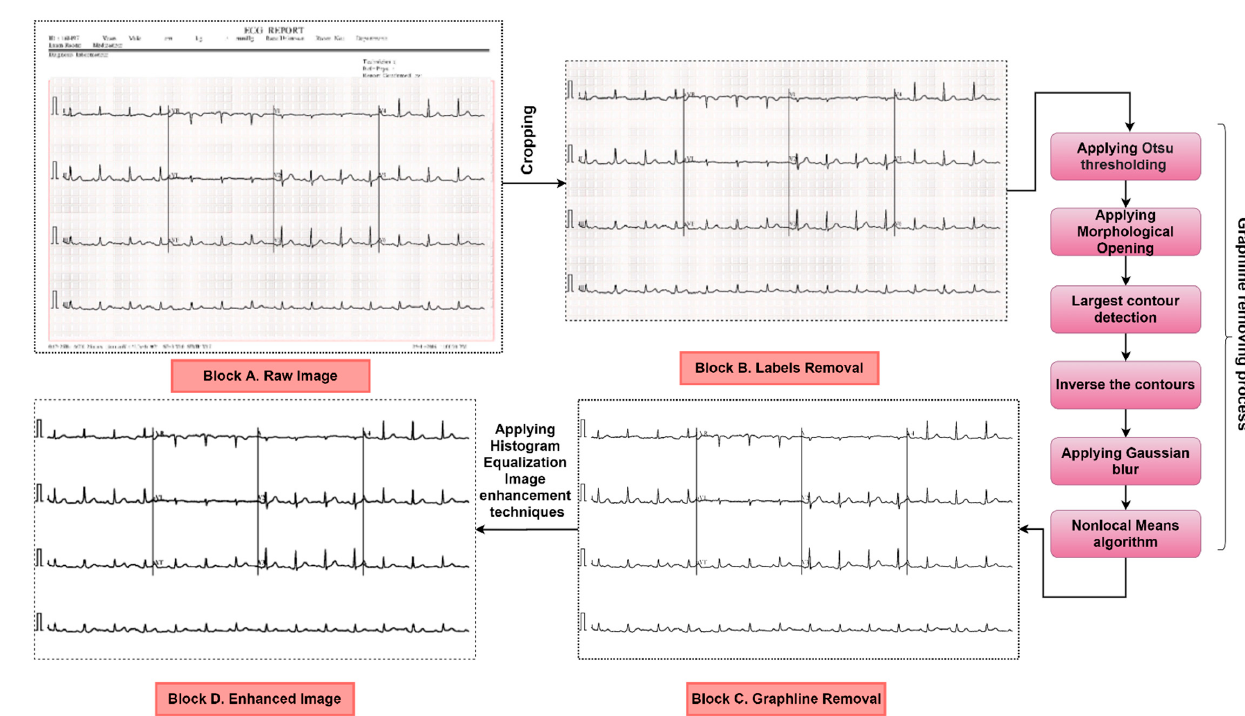
Figure 4. Image pre-processing techniques; Block (A–C) for artifact removal; Block A: Raw image, Block B: Label removal (by applying cropping techniques to the raw images to remove unusual texts and objects), Block C: Graph line removal (applying Otsu thresholding, applying morphological opening, largest contour detection, inverse contour, Gaussian blur, and NLM), and Block D: Applying HE technique to the pre-processed dataset to enhance image quality.